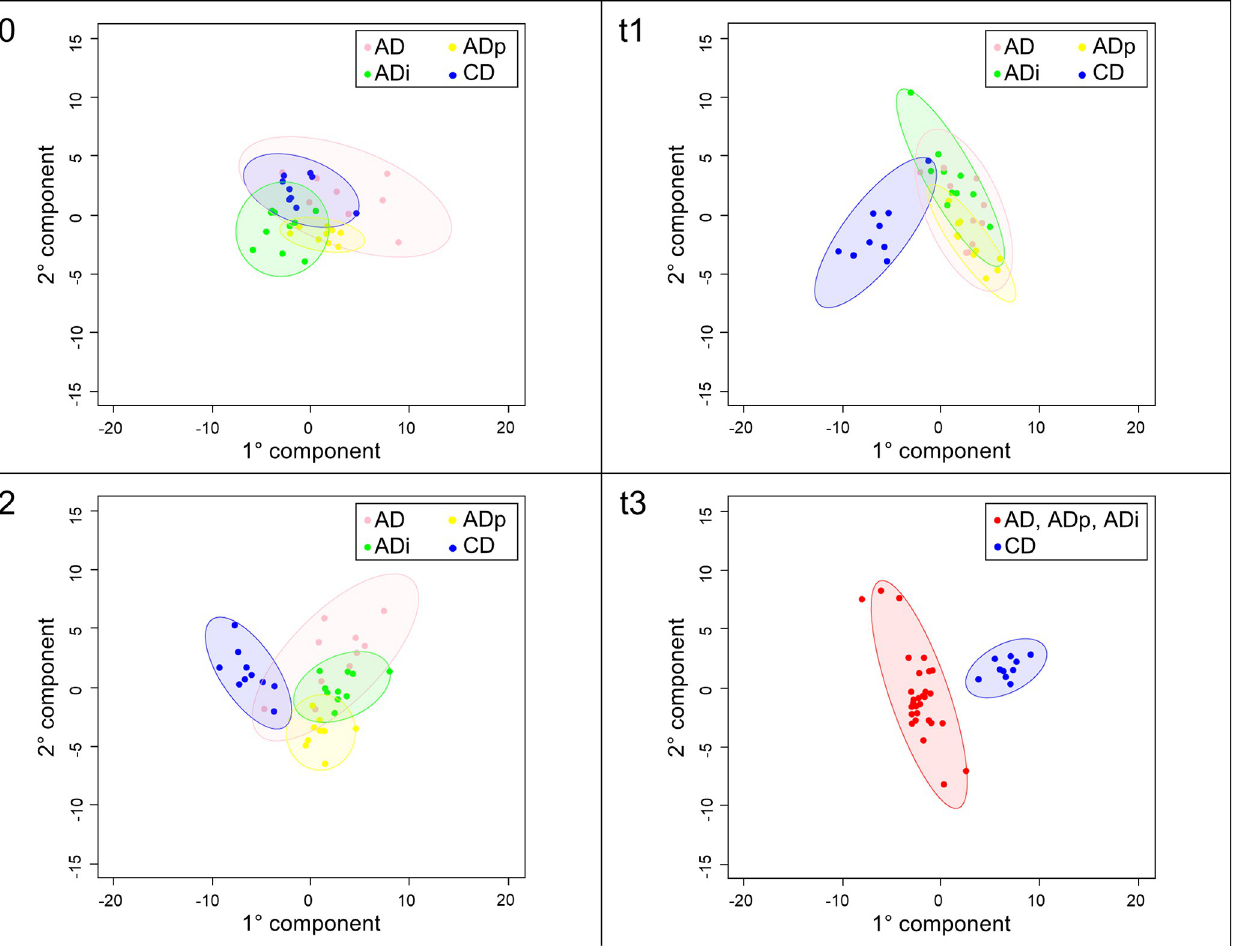
Fig 3. PLS-DA analysis of 1 H NMR spectra of serum samples. Data present the time point before the feed change (t0) and the time points 1–3 months after feed changes (t1–t3) for all feeding groups (AD, ADp, ADi, CD).